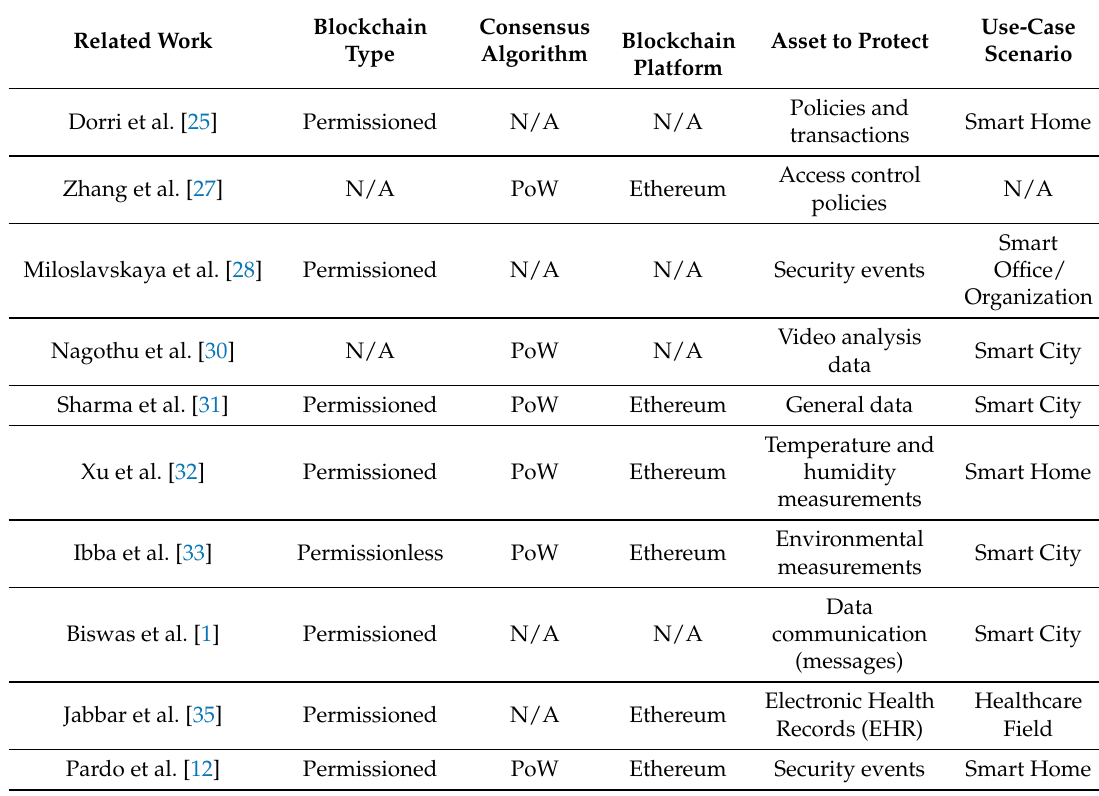
Table 1. Comparative table of the analyzed related